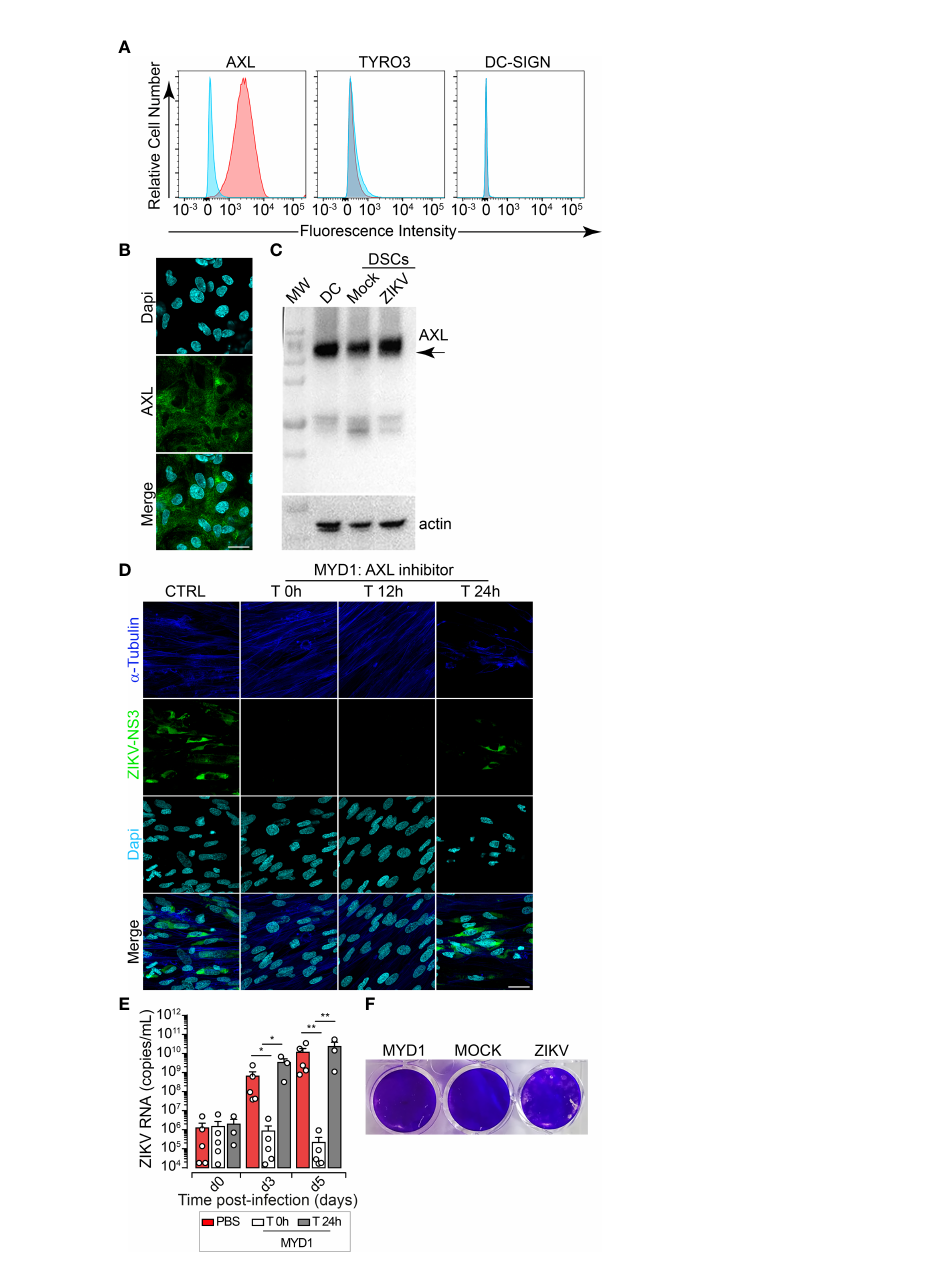
FIGURE 4 AXL Receptor Is Essential for ZIKV Infection of DSCs. (A) Fluorescence immunostaining for cell surface molecules, AXL, TYRO3, DC-SIGN using speci fi c antibodies. Representative histograms gated on live cells are shown. Speci fi c receptor staining (Pink), isotype-matched Ig control (Blue). One representative histogram out of fi ve independent experiments is shown. (B) Representative images of maximum intensity projection of DSCs. AXL (green), DAPI nuclei (cyan). Scale bar, 20 µm. Data are representative of at least fi ve independent experiments from fi ve independent donors. (C) Western blot analysis of AXL expression. b -actin as the loading control, DC (dendritic cells) expressing AXL protein as positive control. (D) ZIKV-DSCs incubated with or without MYD1 decoy receptor, added during infection (T 0h) or 12 hours (T 12h) and 24 hours (T 24h) post-infection. Immunostaining performed 5 dpi in the presence of MYD1 treatment. NS3 (green), a -tubulin (blue) and DAPI nuclei (cyan). Scale bar, 20 µm. Data are representative of at least three independent experiments. (E) ZIKV replication in mock treated DSCs (red) and in DCSs that were treated with MYD1 during the infection(white) or 12 hours post-viral challenge (grey). Viral loads were determined by qRT-PCR at days 0,3 and 5 post challenge. Bar graphs represents the mean values ± SEM determined from fi ve independent donors. P values are computed using one-way ANOVA with the Dunn post hoc test for comparisons of different experimental conditions. *p<0.05, **p<0.01. (F) Monolayers were challenged with culture supernatants collected from uninfected DSCs (MOCK) and from cells that were infected with ZIKV in the presence (MYD1) or absence (ZIKV) of MYD1. Plaques were observed at 5